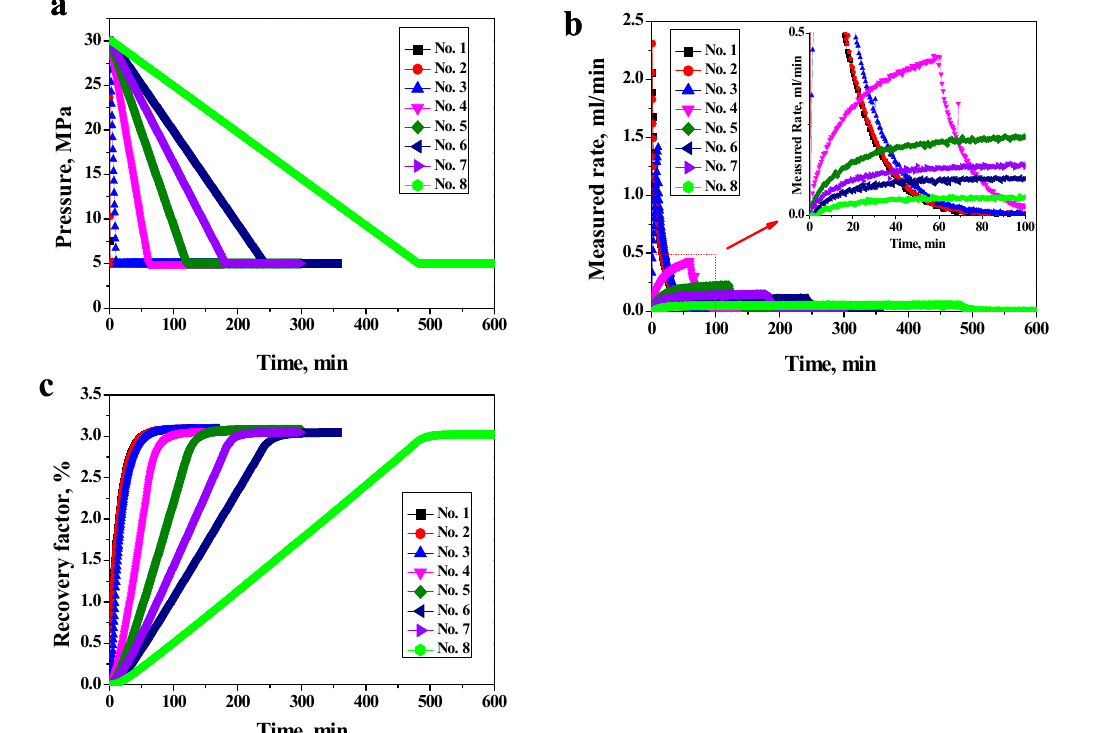
Figure 6. Results of the linear pressure depletion experiments. ( a ) Pressure depletion with different depletion rate; ( b ) Oil production rate with different depletion rate; ( c ) Oil recovery factor with different depletion rate.